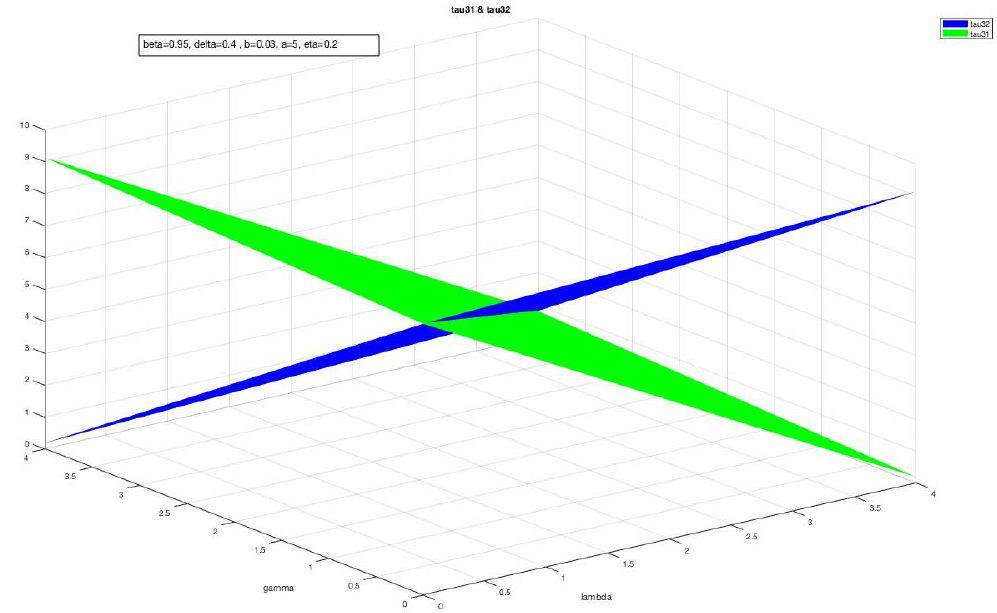
Figure 3. τ 1 and τ 2 depending on λ 2 and γ 2 , where tau31 and tau32 denote, respectively, τ 1 3 3